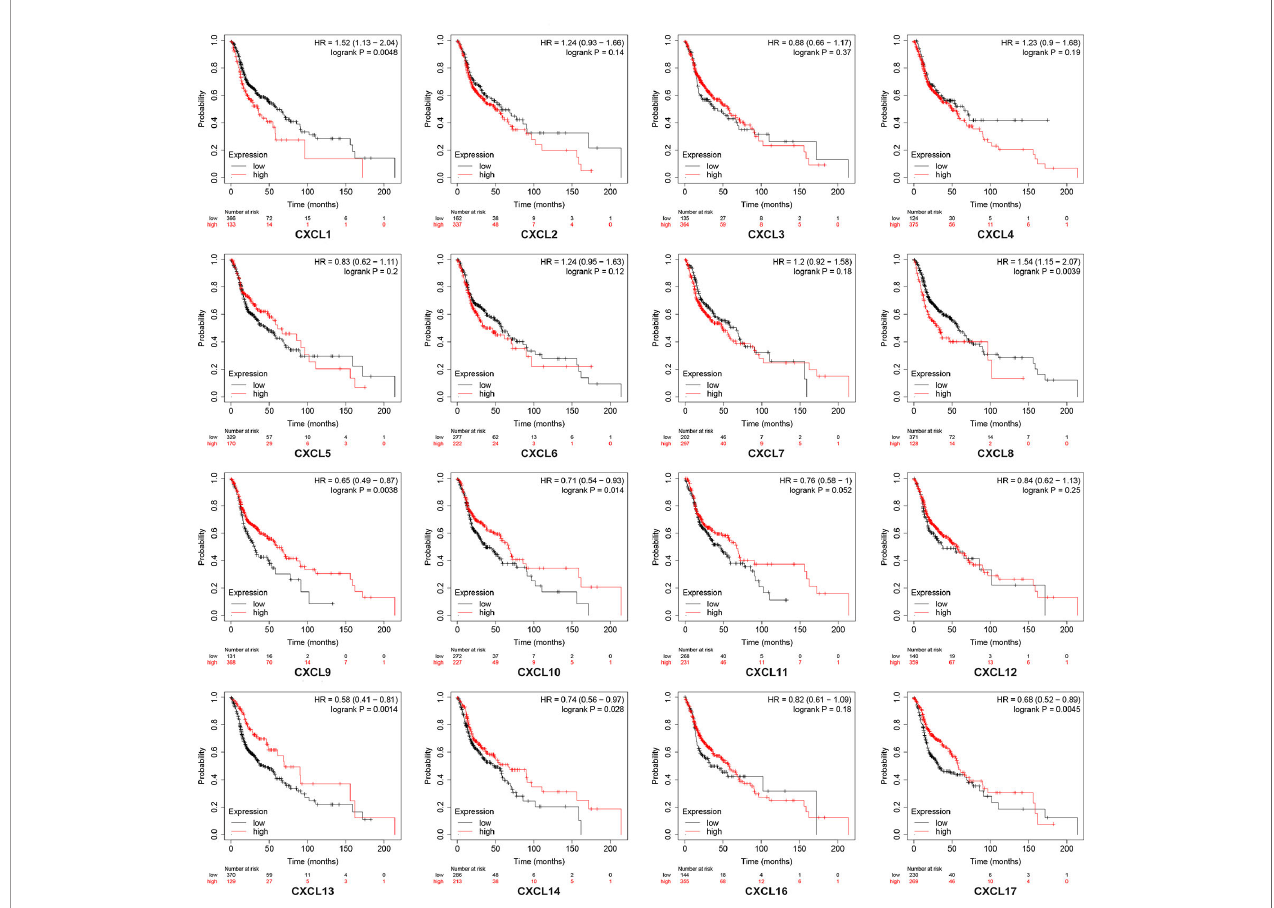
FIGURE 7 | Kaplan-Meier plotter reveals the overall survival differences based on mRNA level of CXC chemokines in HNSCC patients. The threshold of p -value of <